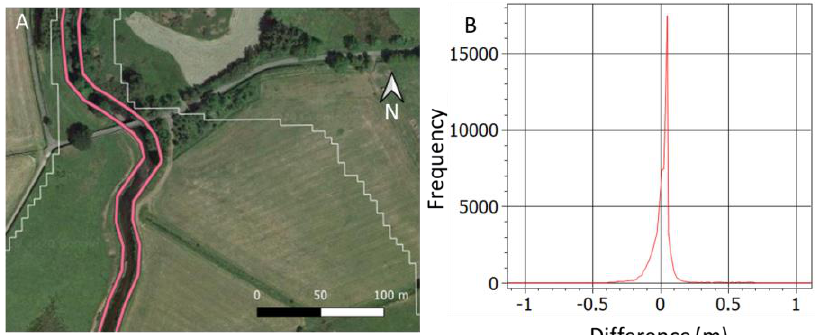
Figure 2. ( A ) Morphological break points (channel, channel margin—purple, overbank / floodplain—white) and ( B ) data difference comparison between lidar and laser point cloud used in change analysis (background imagery © Maxar Technologies / Google).